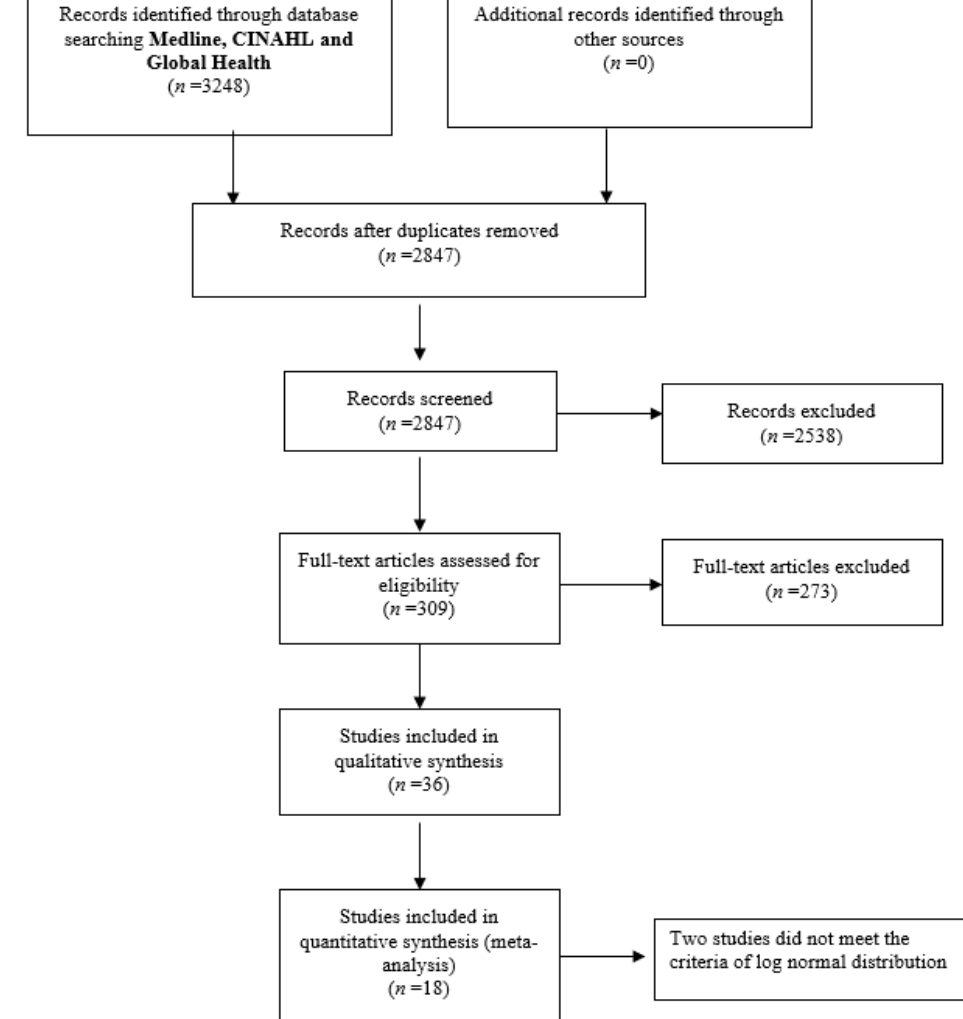
Figure 1. PRISMA flow